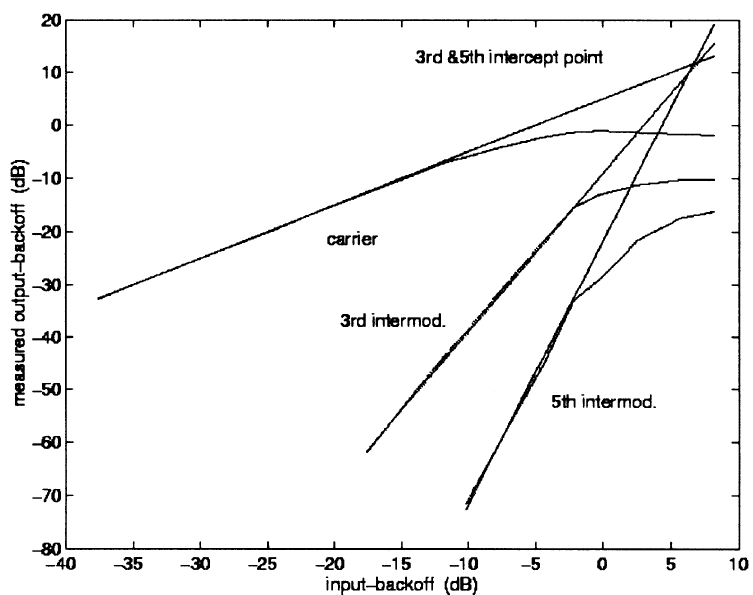
FIGURE 5 Definition of intercept points for the 2-carrier case.